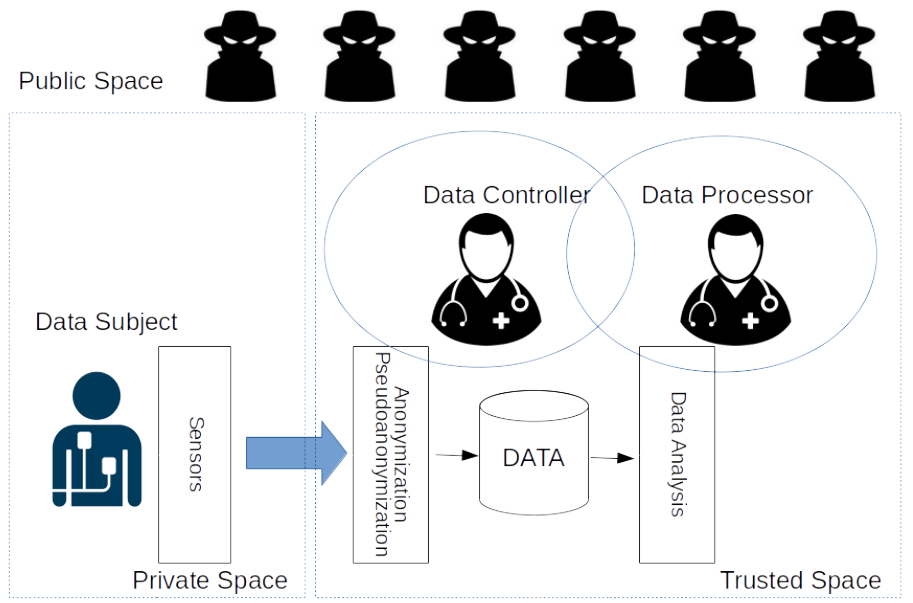
Figure 2. A simplified representation of the common approach in which according to Article 32 of GDPR anonymization and/or pseudoanonymization are in charge of the Data Processor and Data